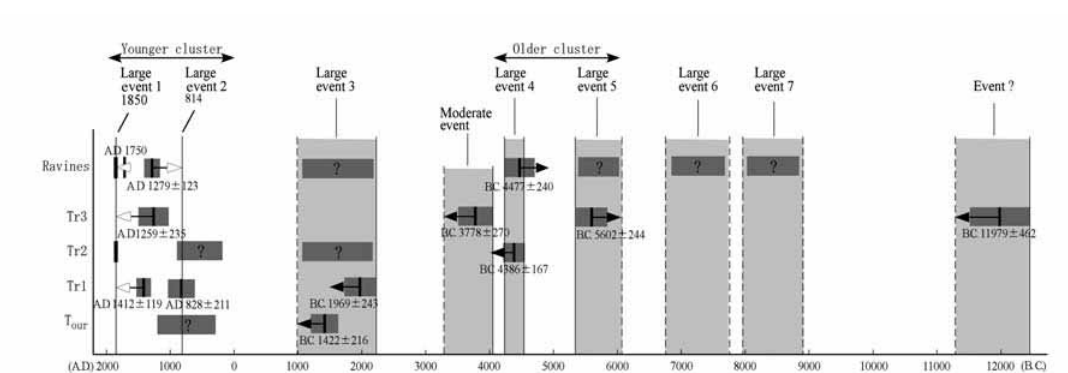
Fig. 10. Seismological history of the Zemuhe Fault based upon historic and paleoseismological data. Tr1, Tr2 is the trench excavated by us in 1997. Arrow and Tr3 are three trenches excavated by Fen et al. (1995), T our with left direction show the upper age limit of paleoearthquakes, while arrow pointing rightwards indicates the lower age limit of paleoearthquake. The unfilled arrow indicates that the seismic event dated by radiocarbon sample is actually a historical earthquake. Dark gray rectangles show the errors on the radiocarbon dating. Question marks within dark gray rectangles indicate an inferred paleoearthquake without dating. Double-arrow shows temporal cluster of seismic activity. Light gray rectangles show preferred ages for the paleoearthquakes; thin vertical lines shows possible age bound of the paleoearthquake, while dashed line shows no age bound of the